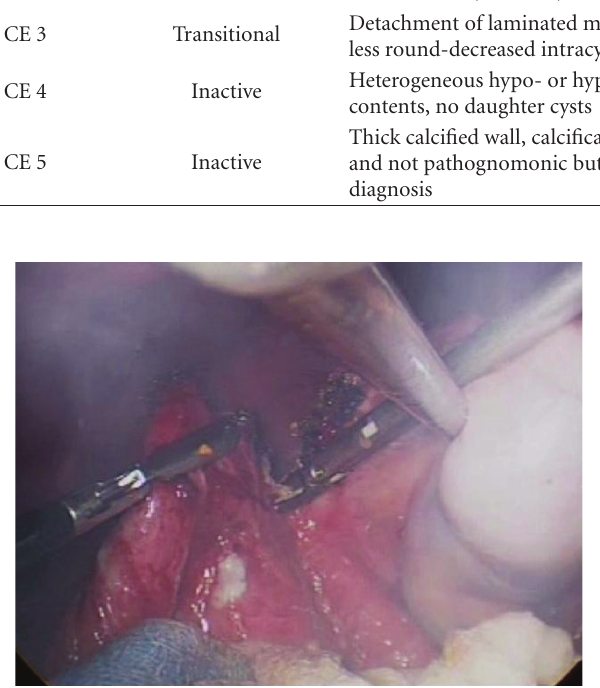
Figure 5: Excision of cyst wall using a harmonic scalpel.